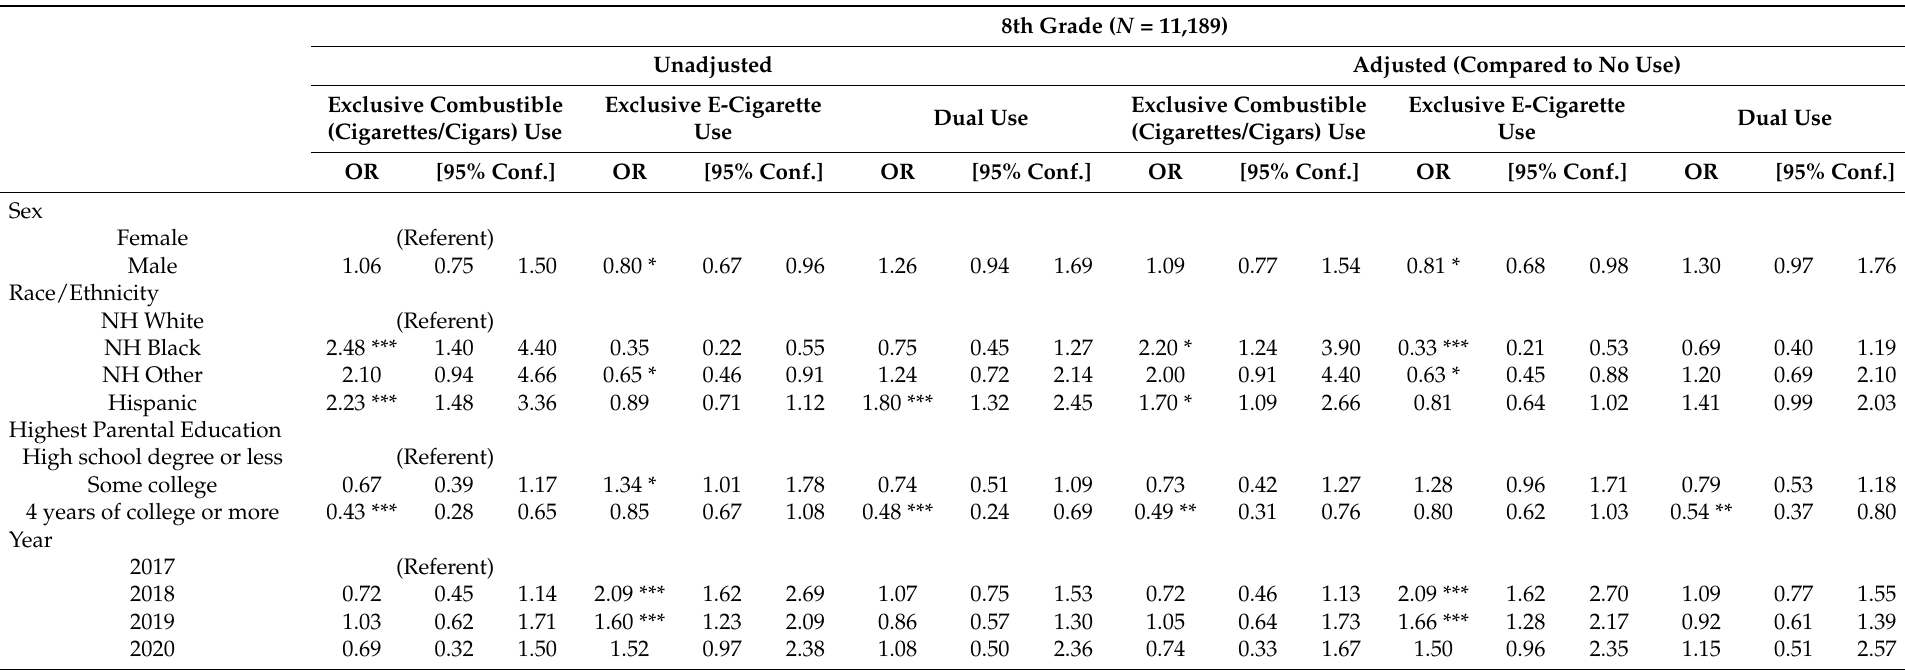
Table 2. Multinomial Regression Models of Sociodemographic Factors associated with Exclusive and Dual use of E-cigarettes with Combustibles (cigarettes and cigars) among eighth graders: Monitoring the Future Surveys, 2017 to